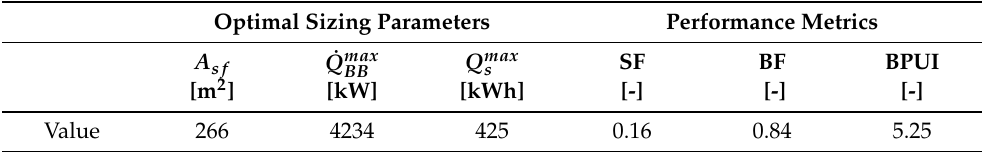
Figure 6. Distribution of the hourly thermal demand of the greenhouse ( Q g ) and desalination facility ( Q D ) throughout the year under consideration. Table 3. Values of the optimal sizing parameters and performance